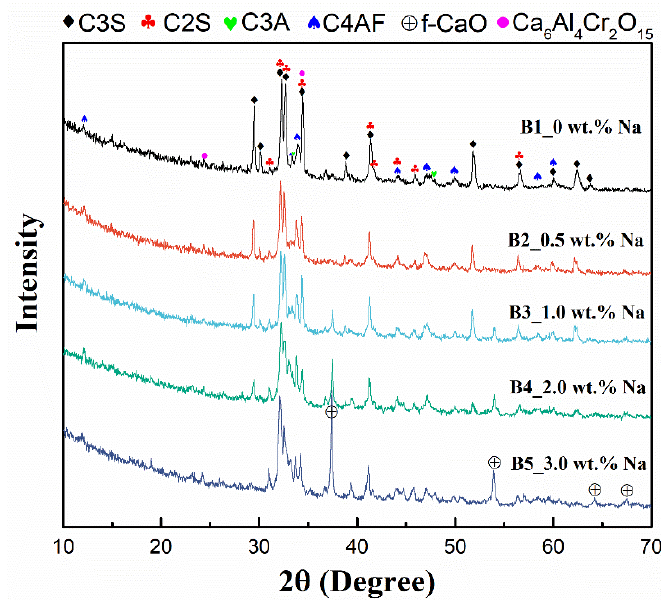
Figure 1. X-ray diffraction patterns of leach residues of samples B1–B5.